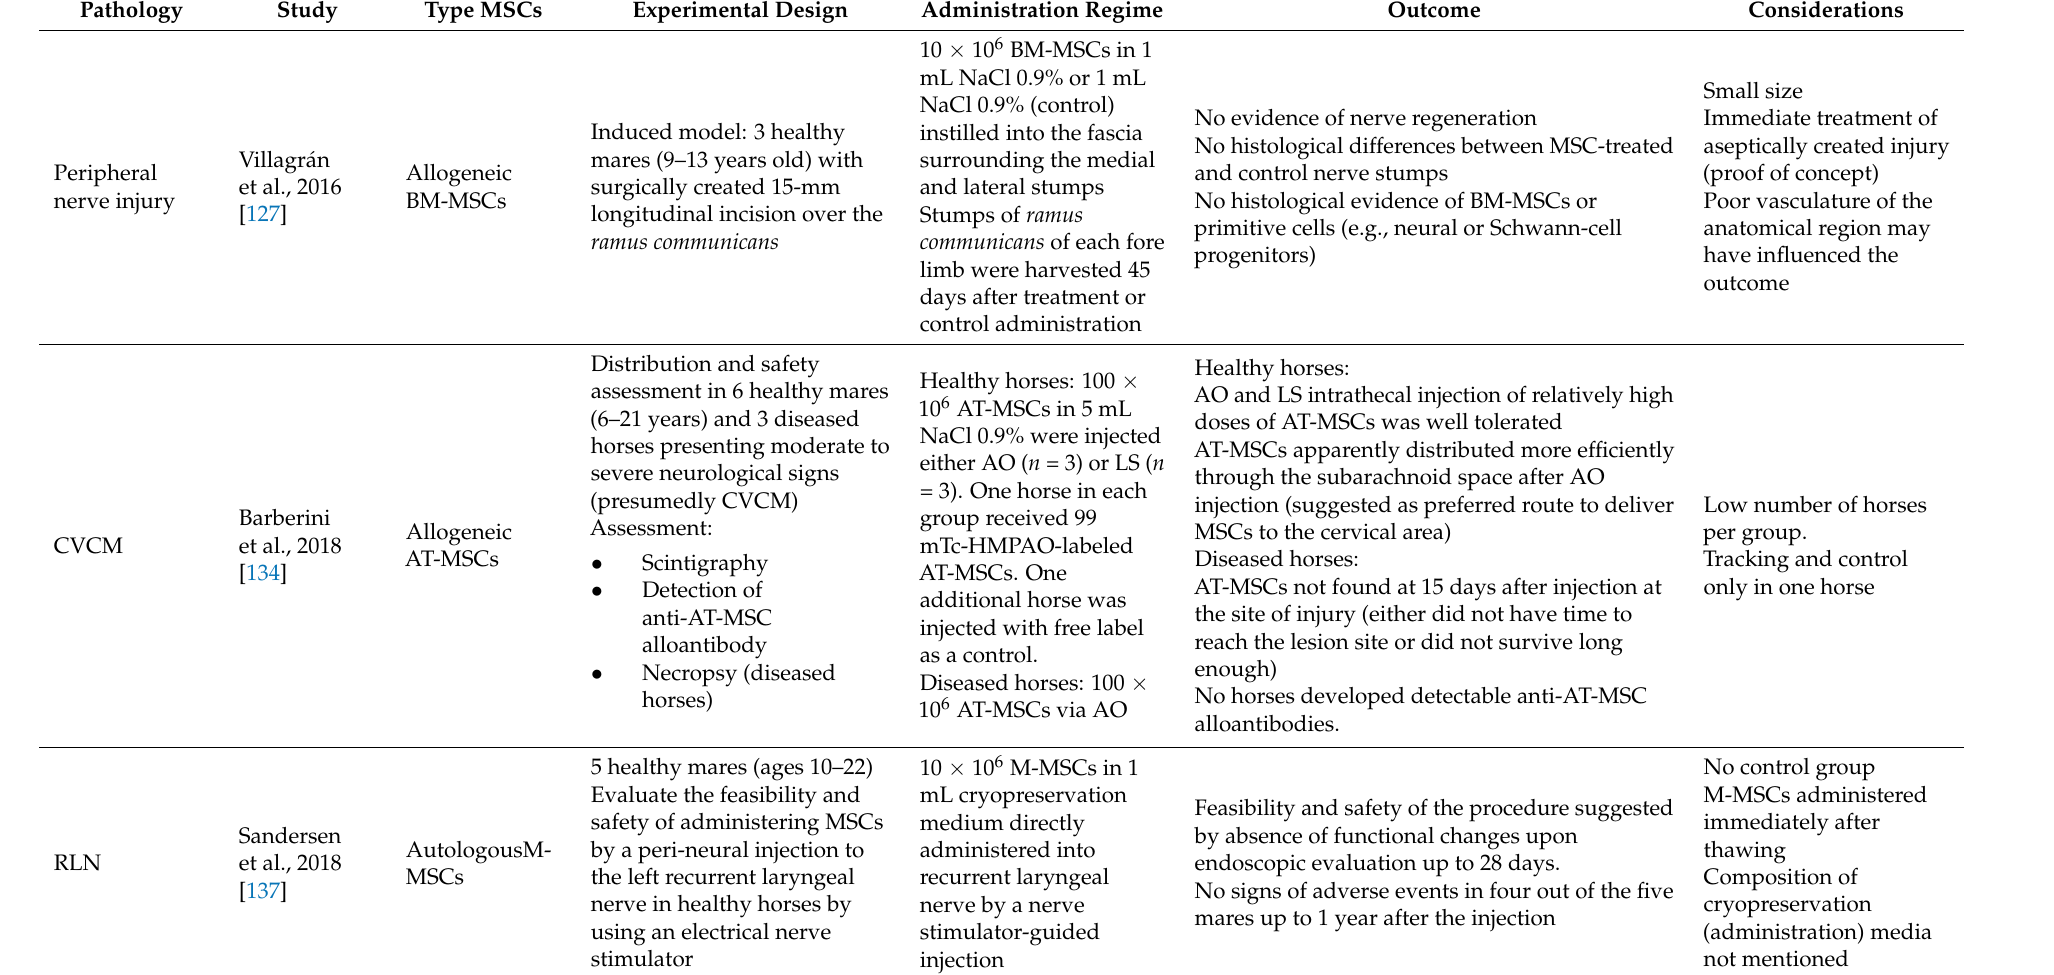
Table 4. In vivo studies using mesenchymal stem cells in equine neurological disorders. Bone marrow mesenchymal stem cells (BM-MSCs), adipose tissue MSCs (AT-MSCs), cervical vertebral compressive myelopathy (CVCM), 99m technetium-hexamethyl-propylene-amine-oxyme (99mTc-HMPAO), atlanto-occipital (AO), lumbosacral (LS), recurrent laryngeal neuropathy (RLN), muscle-derived MSCs